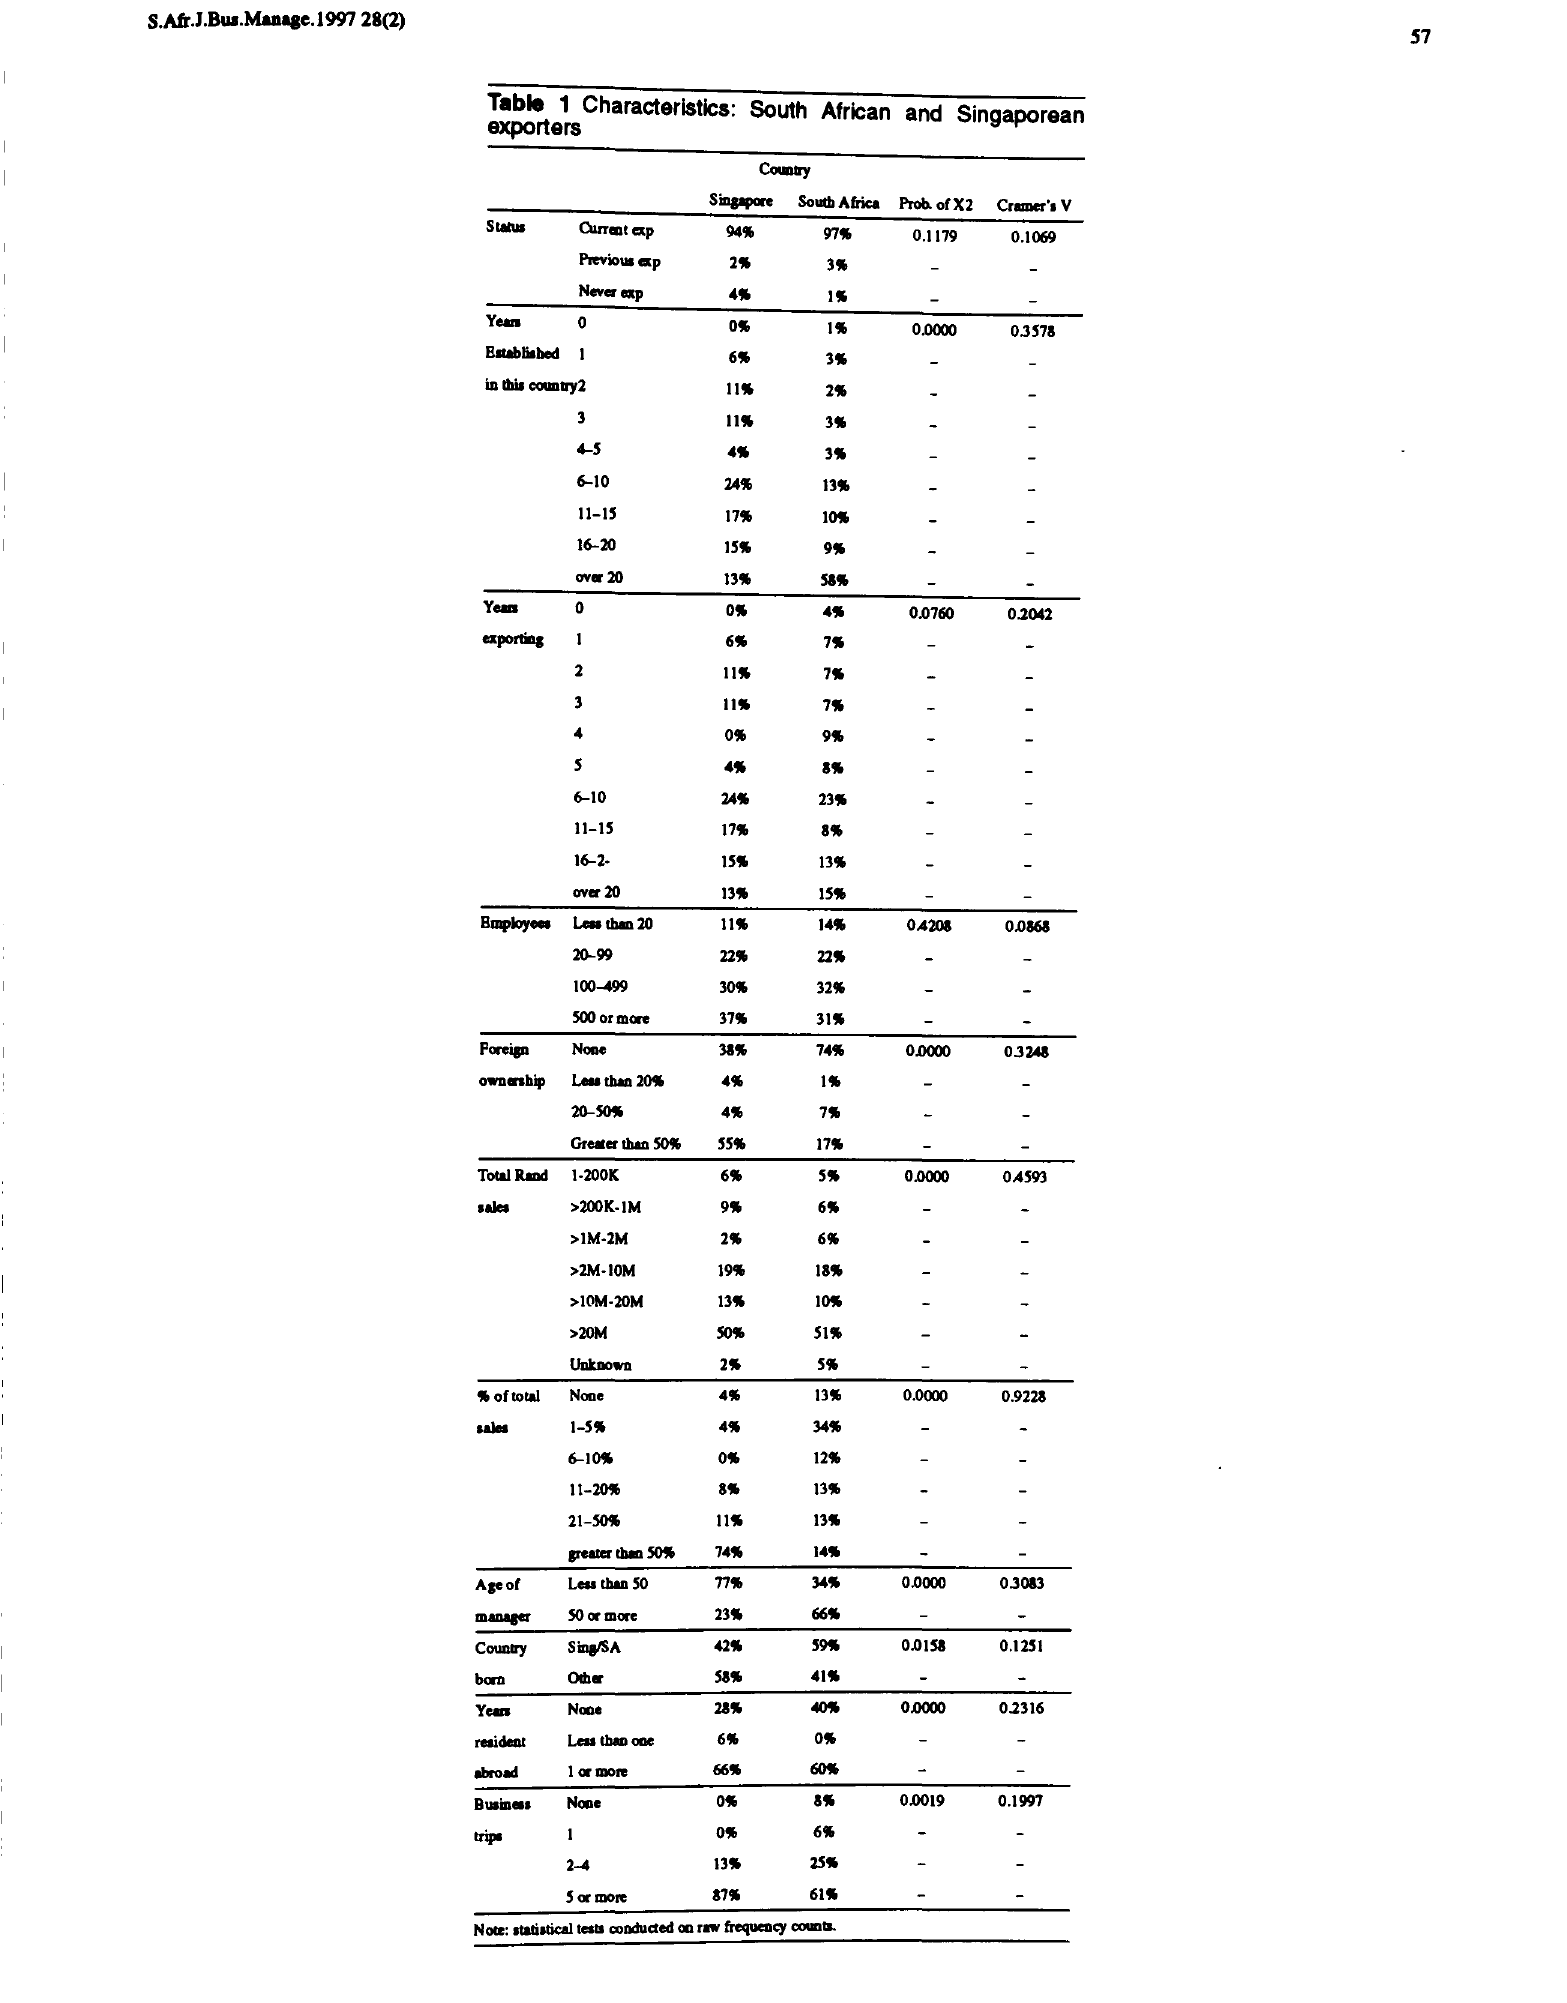
Table 1 Characteristics: South African